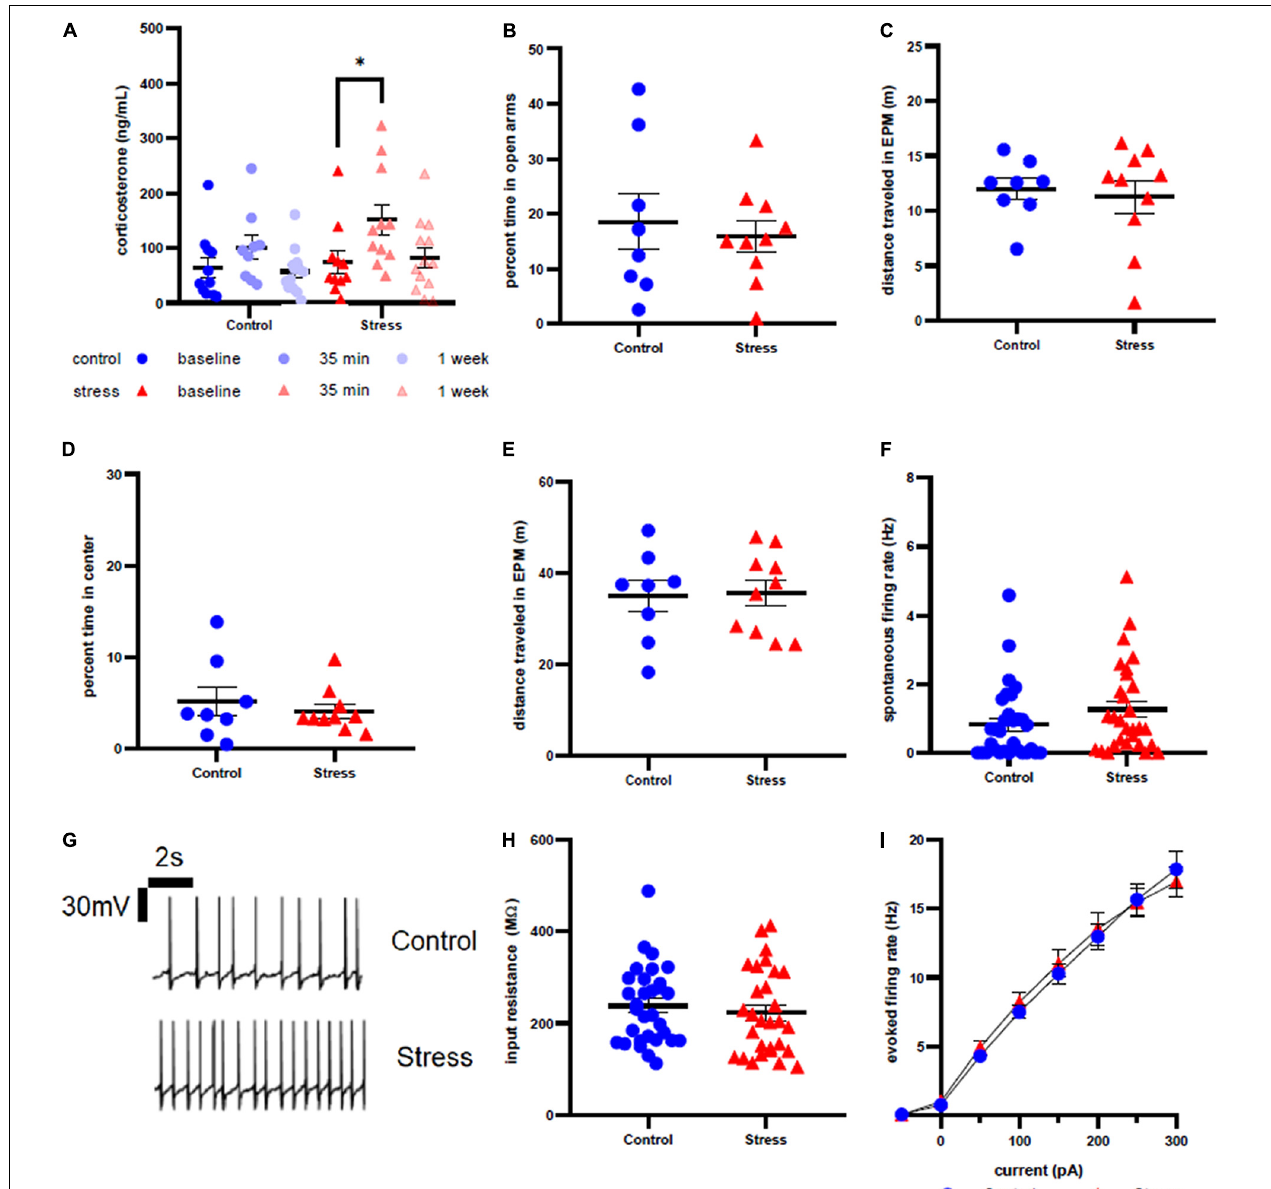
FIGURE 4 | Stress response in adult female rats. (A) Serum corticosterone concentration is higher 35 min after stress compared to baseline. (B) There is no effect of stress on time spent in open arms of the elevated plus maze immediately after stress or control conditions. (C) There is no effect of stress on distance traveled in the elevated plus maze immediately after stress or control conditions. (D) There is no effect of stress on time spent in the center of the open field test one week after stress. (E) There is no effect of stress on distance traveled in the open field test one week after stress. (F) There is no effect of stress on spontaneous firing rate of LC neurons one week after stress. (G) Representative traces for spontaneous firing in control (top) and stress (bottom) groups. (H) There is no effect of stress on input resistance of LC neurons one week after stress. (I) There is no effect of stress on the excitability of LC neurons one week after stress. ∗ p <